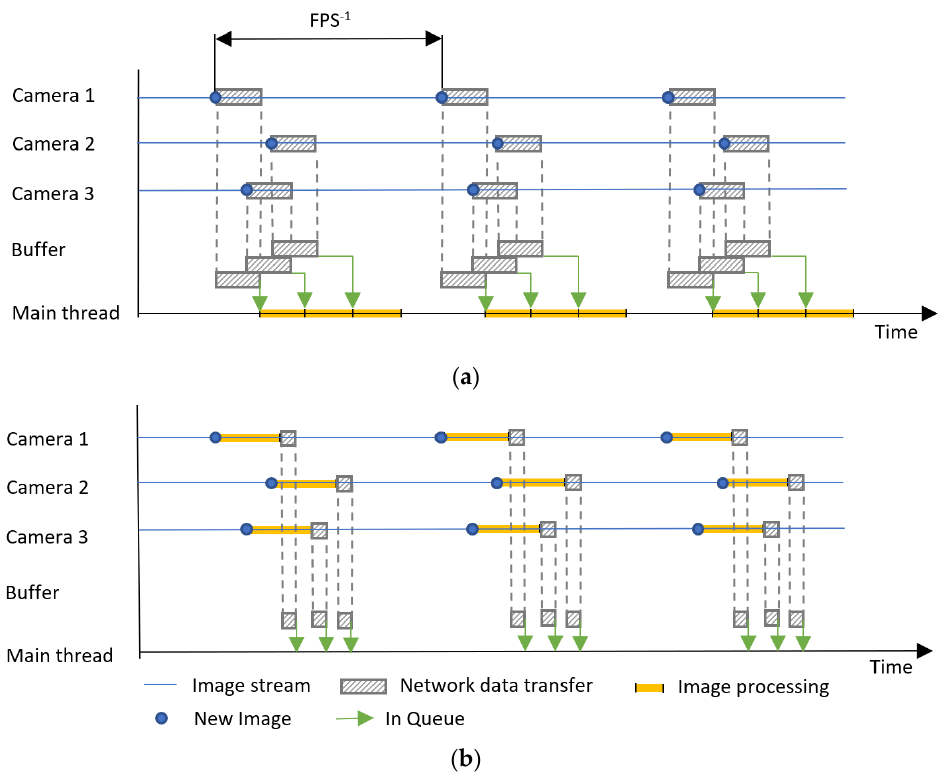
Figure 10. Diagram of the system principle: ( a ) centralized; ( b ) distributed.